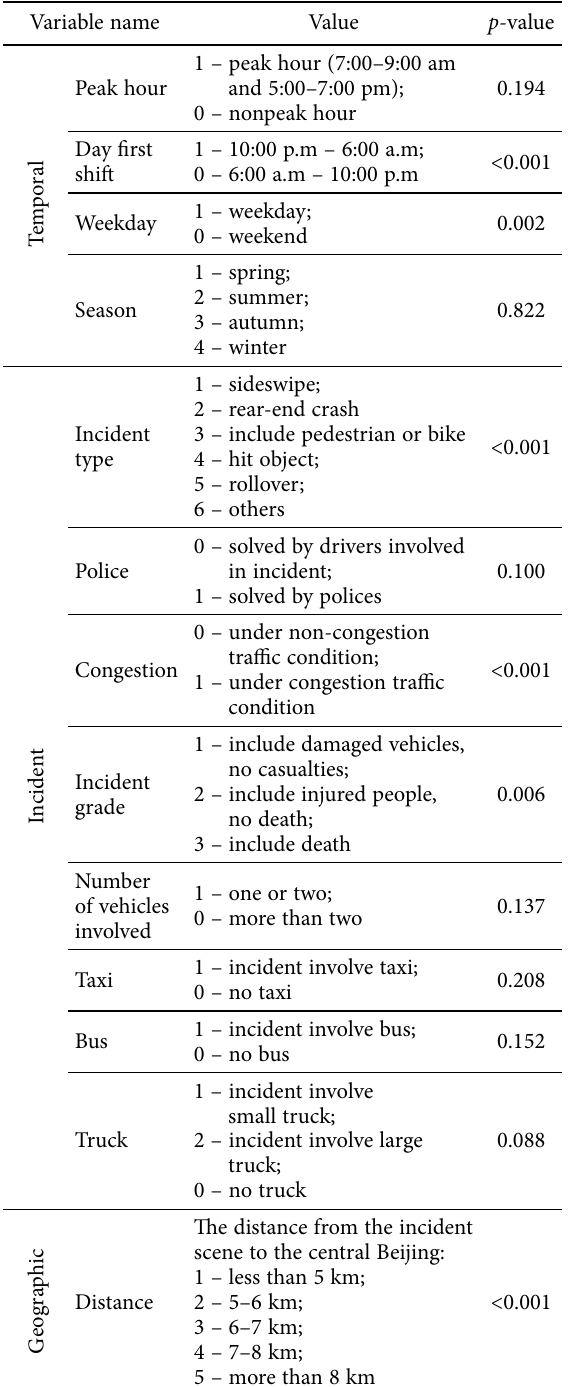
Table 1. Variable Kruskal–Wallis test